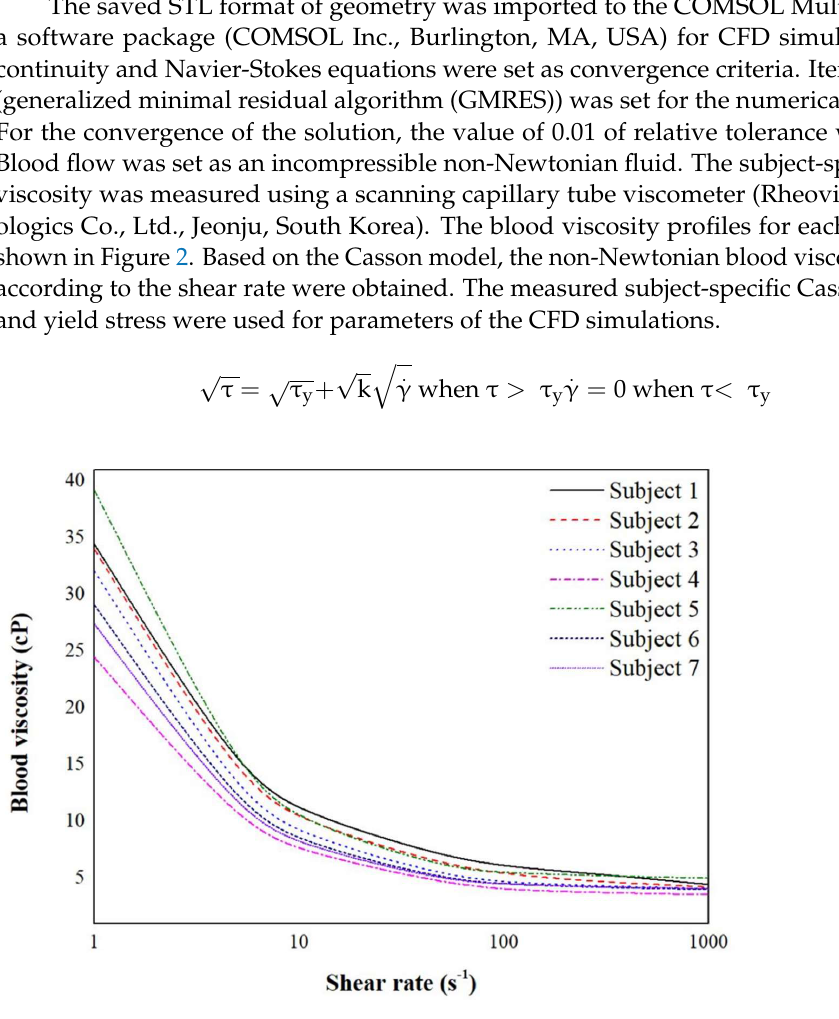
Figure 2. The whole blood viscosity profiles for each subject according to shear rate. Subject-specific blood viscosity profiles are shown with different lines.